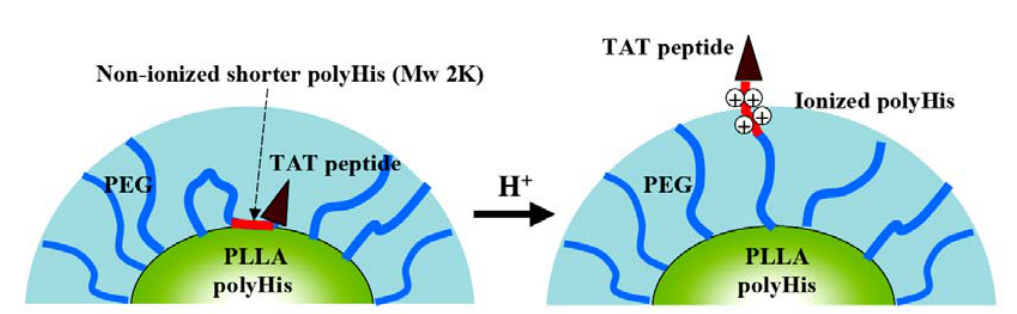
Figure 3. Schematic representation of the acid-induced pop-up targeting mechanism (PHSM pop-upTAT ) of the peptide-conjugated micelle corona. See text for details. Reproduced with permission from reference